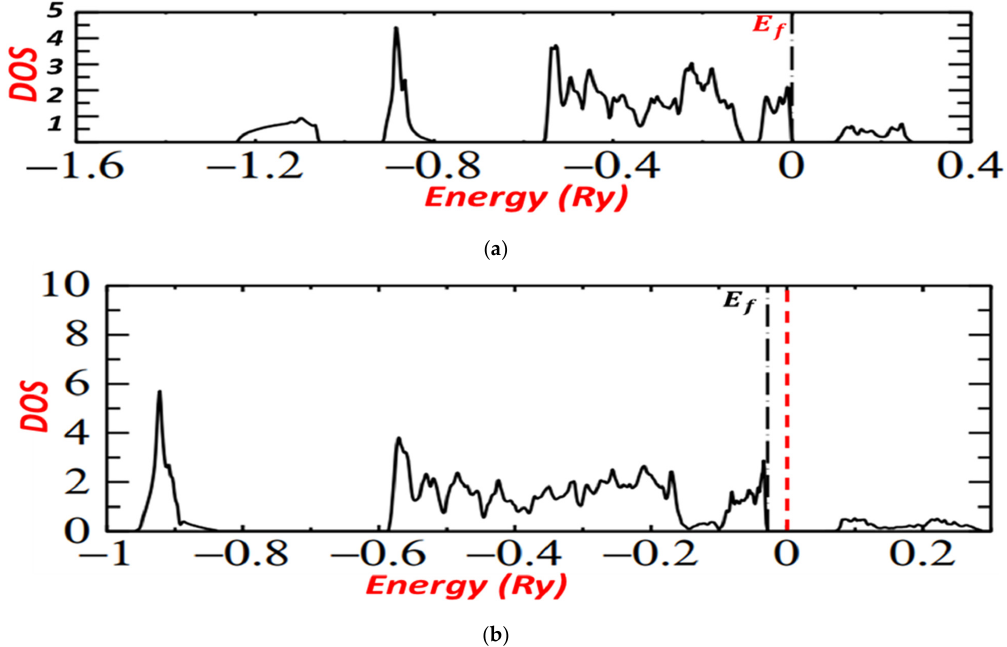
Figure 6. ( a ): DOS for 𝐹𝑒𝑆 (cid:2870) pyrite at the temperature 400 °C. ( b ): DOS for 𝐹𝑒𝑆 (cid:2870) pyrite at the tem- perature 350 °C.